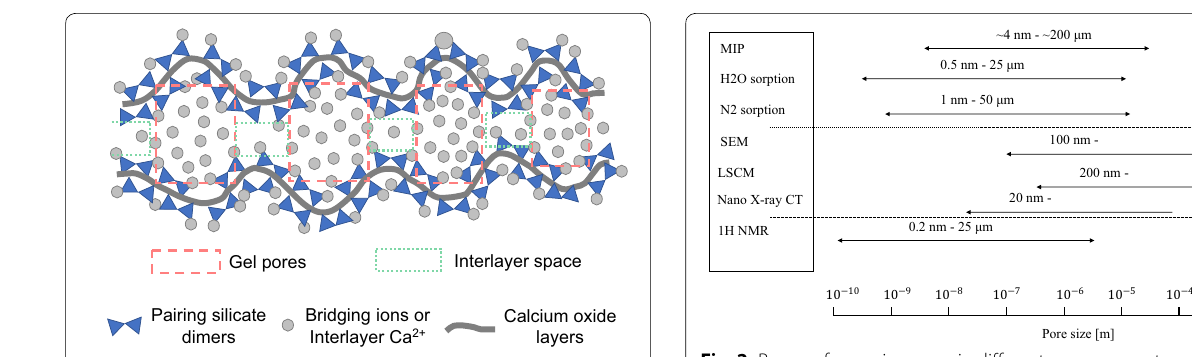
Fig. 1 Schematic representation of gel pore and interlayer space in C–S–H by winding calcium oxide layers.